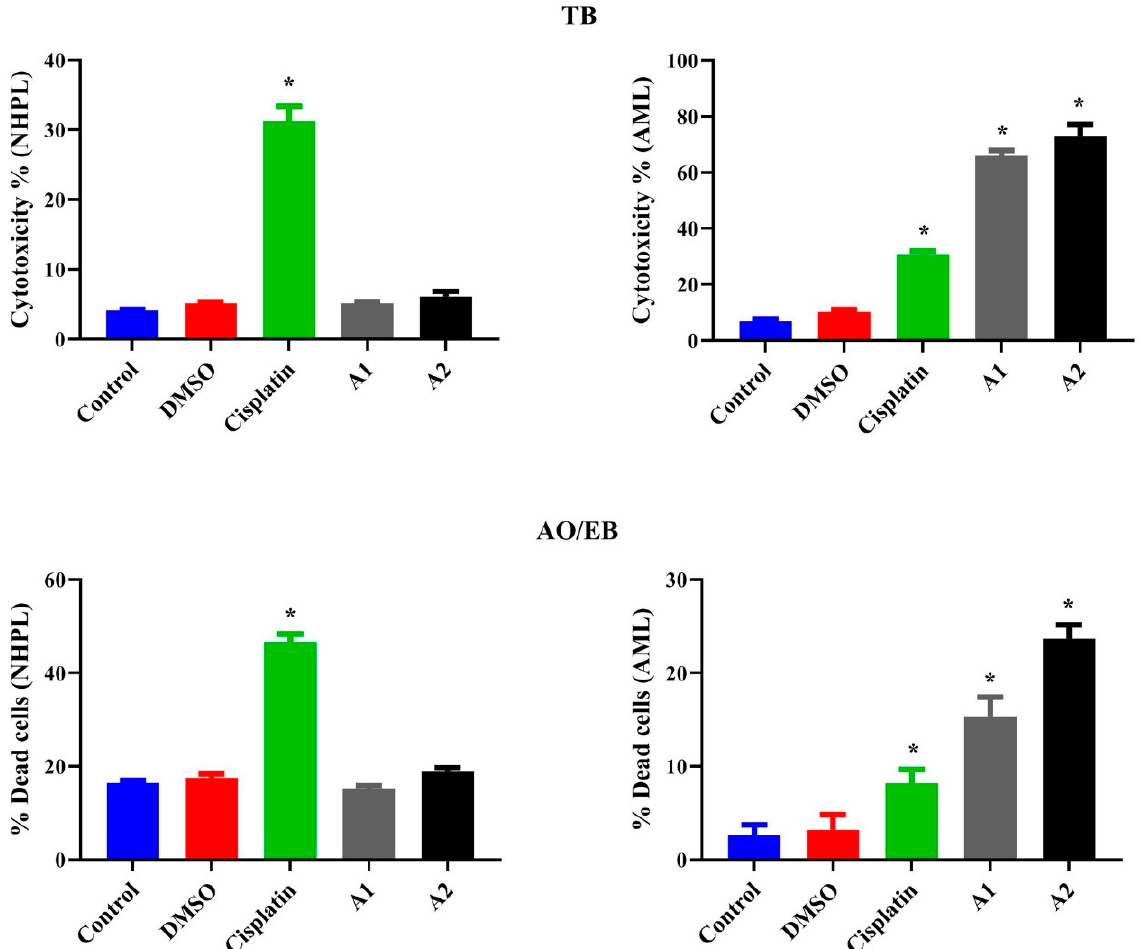
Figure 5. The extract induced dose-dependent cytotoxicity (IC 50 : 0.38 ± 0.02 µ g/mL) in AML cells against serial concentrations. The extract induced an increase in the cytotoxicity by approximately 9.5 and 10.4-folds for A1 and A2, respectively, when compared with untreated cells. However, acridine orange/ethidium bromide dual-fluorescence staining revealed the same pattern of cytotoxicity, with approximately 5.8 and 9.1-folds for A1 and A2, respectively, when compared with untreated cells; see Figure 6. Otherwise, no significant toxicity was observed with NHPL, except for the cisplatin-treated cells, which showed significant ( p < 0.05) toxicity when using both staining methods.